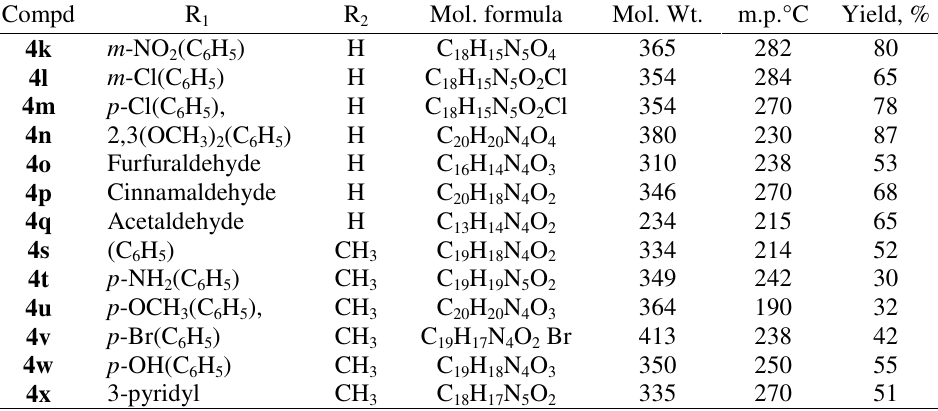
Table 2. Characterization data of compounds ( 4k-4q & 4s-4x